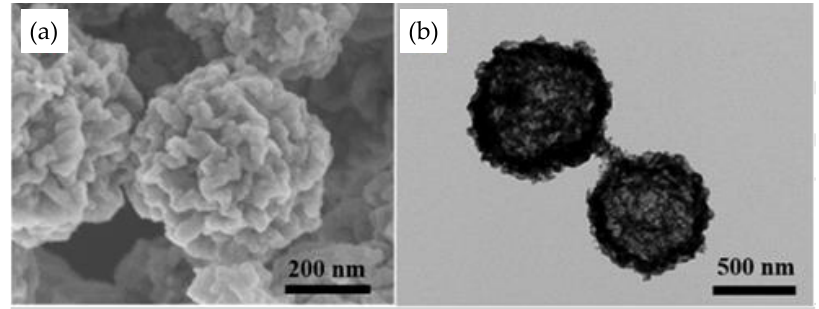
Figure 9. SEM ( a ) and TEM ( b ) of CuFe 2 O 4 hollow spheres [202].